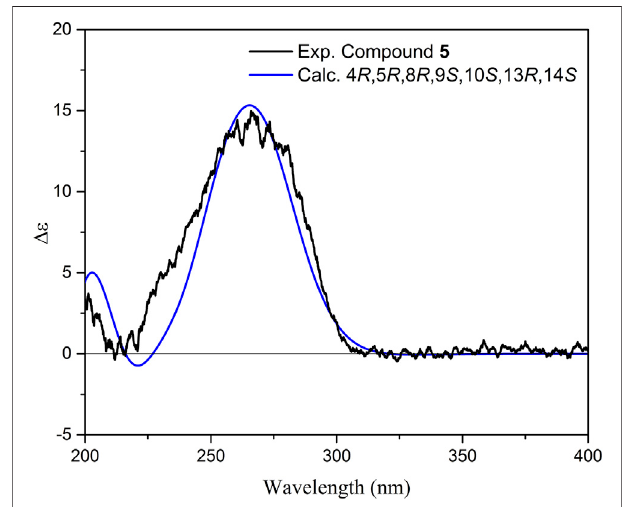
FIGURE 9 | Comparison of experimental and calculated ECD spectra of compound 6 at TD-DFT/B3LYP/6-31+G(d,p) basis set and level of theory in